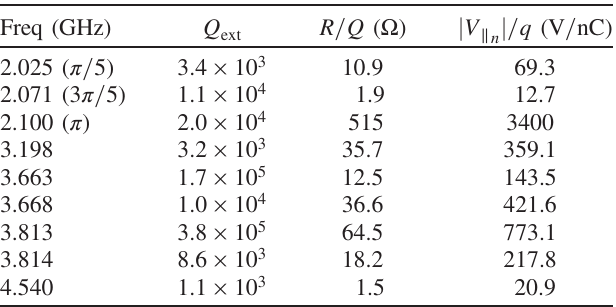
TABLE IV. Simulation results for the monopole modes with R=Q > 1 Ω . Freq (GHz)